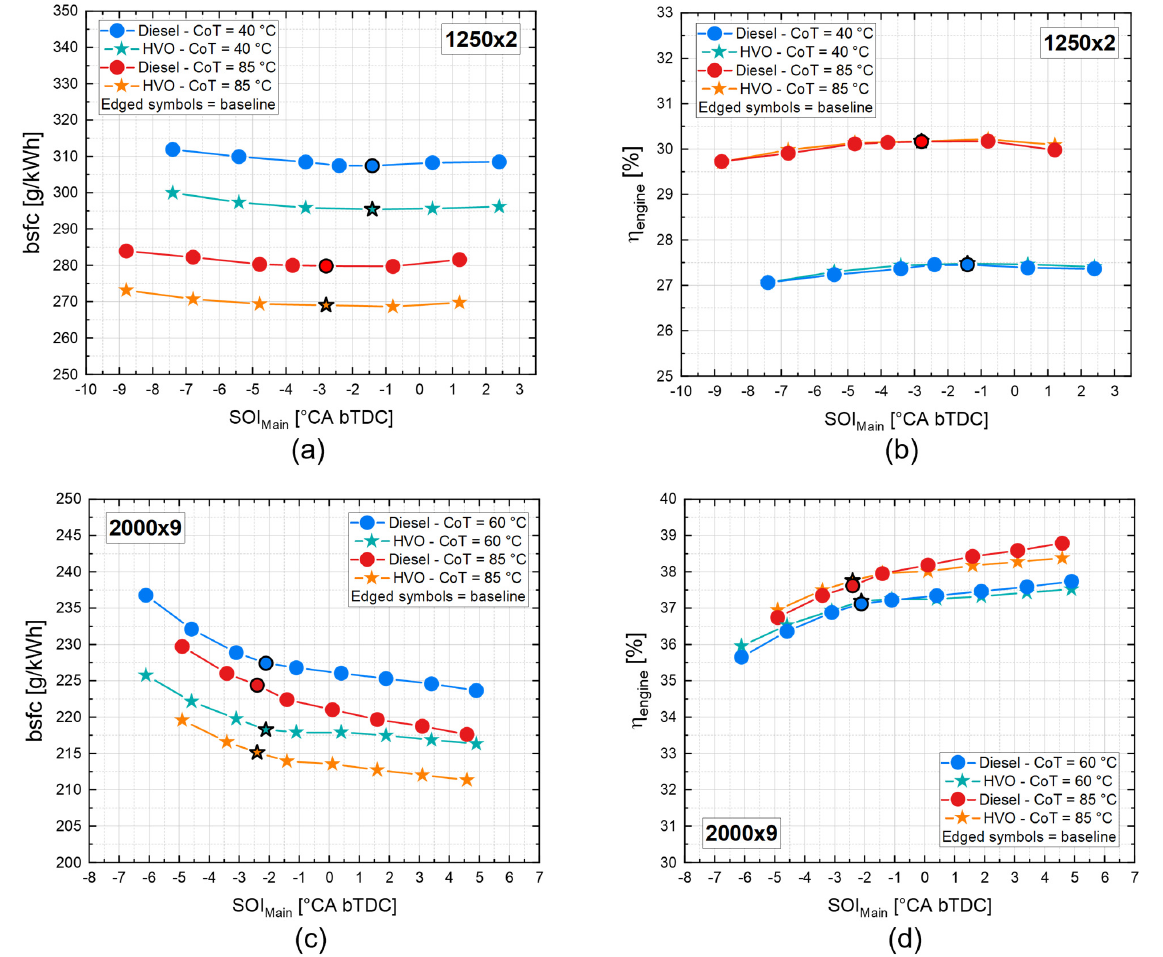
Figure 10. bsfc and engine efficiency along SOI Main sweep tests at 1250 × 2 ( a , b ) and 2000 × 9 ( c , d ). Comparison between diesel and HVO at high and low coolant temperatures. Warm colors represent high coolant temperatures, while cool colors represent low coolant temperatures. Circles represent diesel, while stars represent HVO.